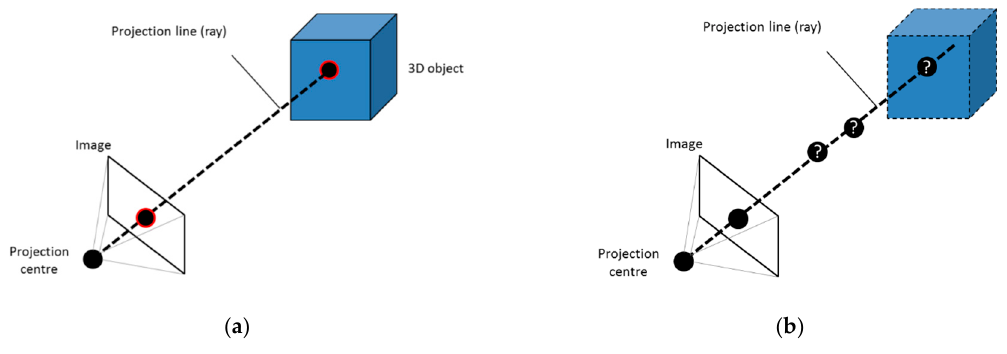
Figure 2. From 3D to 2D. ( a ) Direct problem; ( b ) Inverse problem.